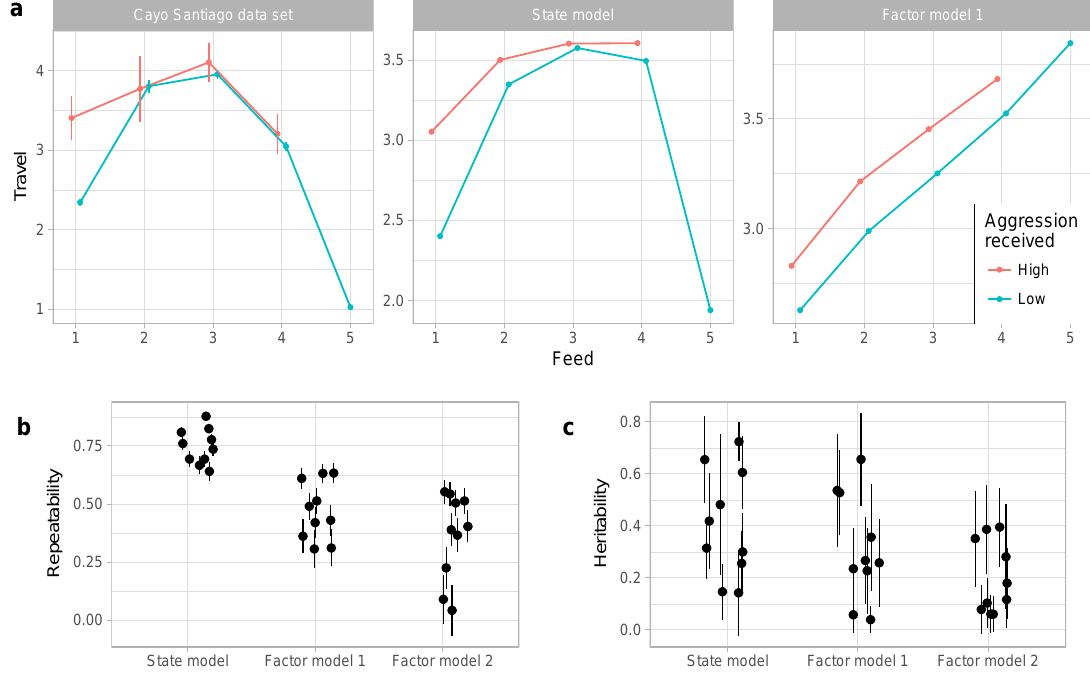
Figure 8. Comparisons between the state model and factor analysis models. ( a ) The leftmost panel shows observed means and standard errors of rates of Travel at varying levels of Feed and Noncontact Aggression (received); The right two panel shows the expected levels of Traveling under the state model and factor model 1; ( b ) Repeatability, as measured by the correlation between 2012 and 2013 phenotypes, for the three models; ( c ) Heritability estimates of phenotypes from the three models. Error bars in all panels represent one standard